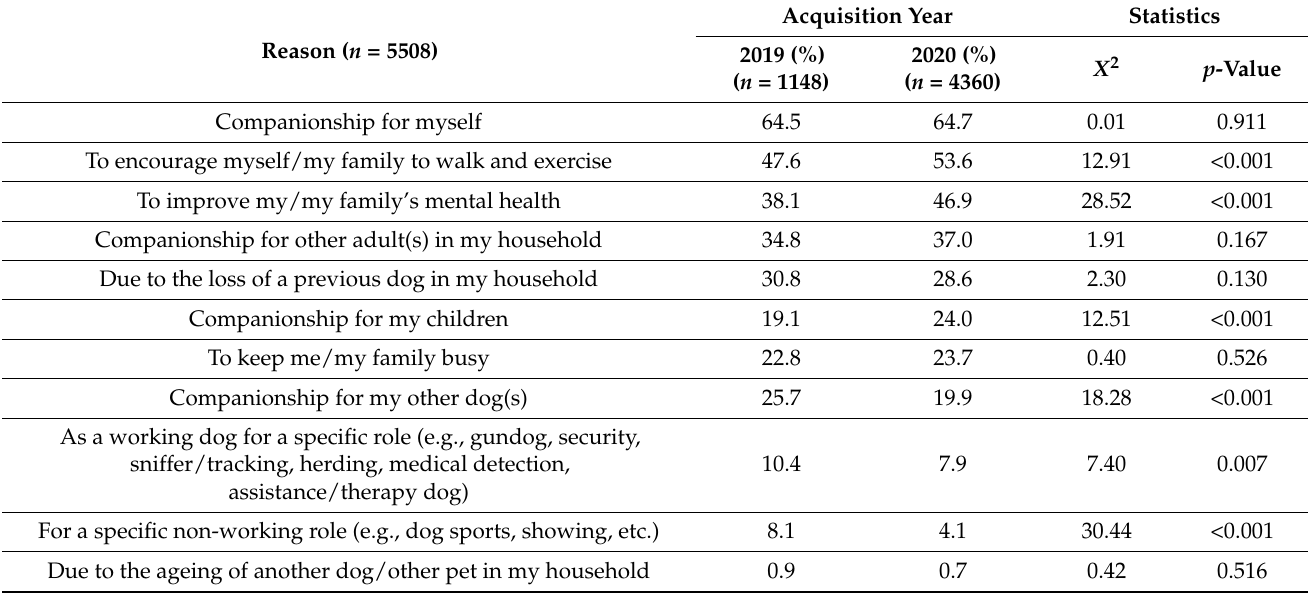
Table 2. Comparison of reasons why UK owners wanted to purchase a dog, compared between 2019 puppy ( n = 1148) and Pandemic Puppy ( n = 4360) owners in the